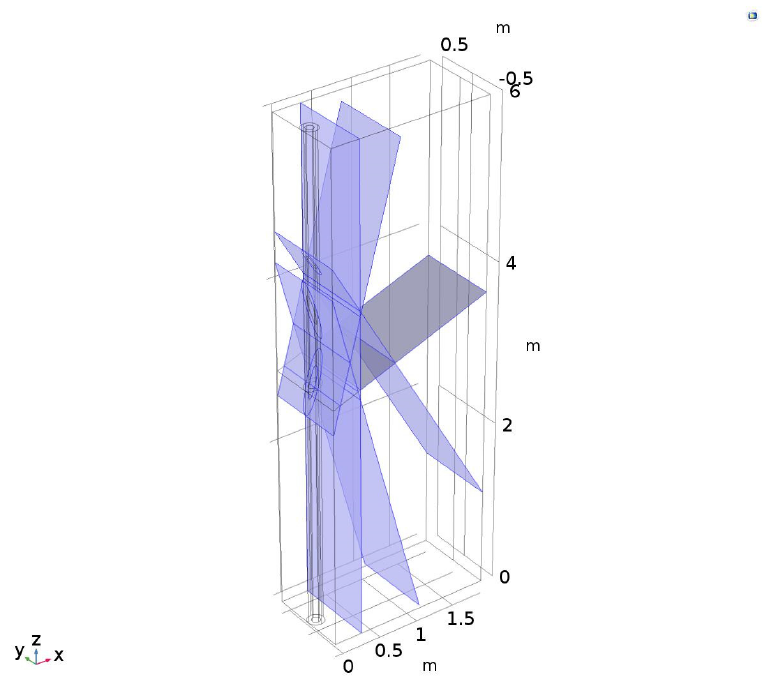
Figure 8. Illustration of the numerical model setup. The cylinder on the left is the wellbore. The hollow cylinder outside the wellbore represents the well skin. The blue planes represent the fractures within the matrix.